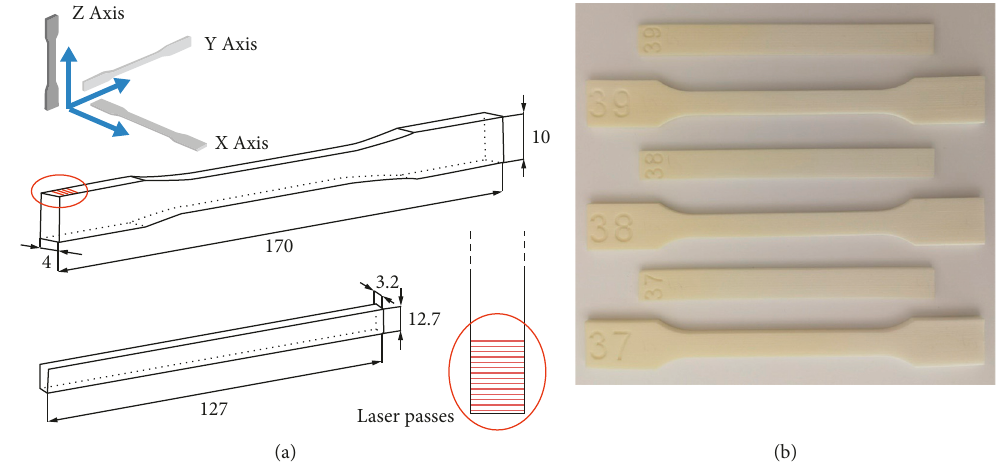
Figure 2: (a) Specimens design dimensions. (b) Printed specimens.